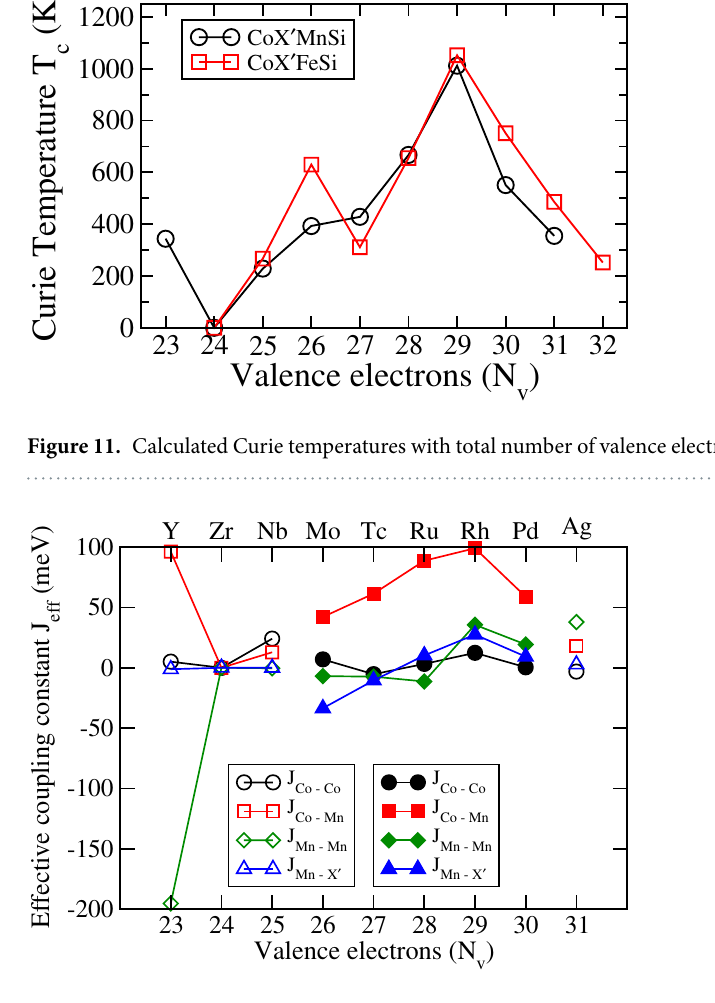
Figure 12. Effective exchange coupling constants for CoX ′ MnSi alloys. Open symbols: Type-I structure, Filled symbols: Type-II